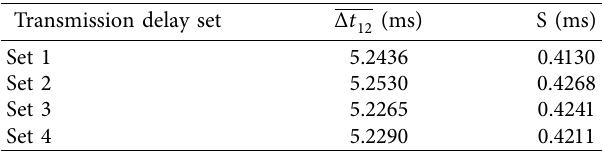
Table 1: Random transmission delay sample mean ( Δ t sample standard deviation ( S ).